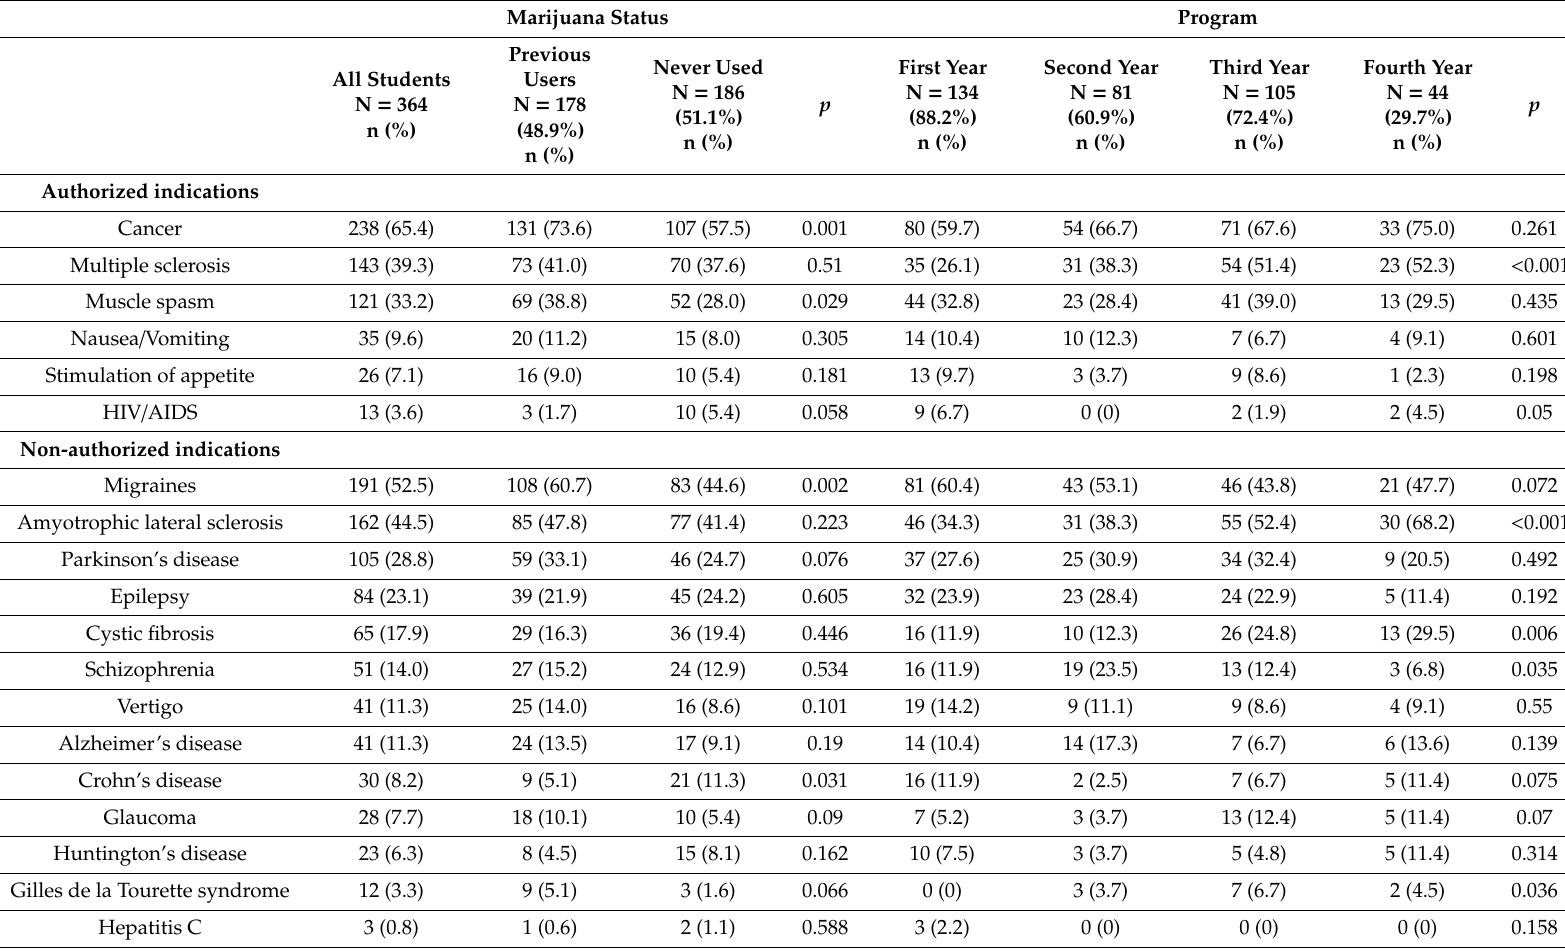
Table 2. Uses of cannabinoid-based medicines authorized in European Union countries. Students were asked about which of the indications suggested were indications of cannabinoid-based medicines. Statistical significance ( p < 0.05) was determined by chi-square test. Abbreviations: AIDS, acquired immunodeficiency syndrome; HIV, human immunodeficiency